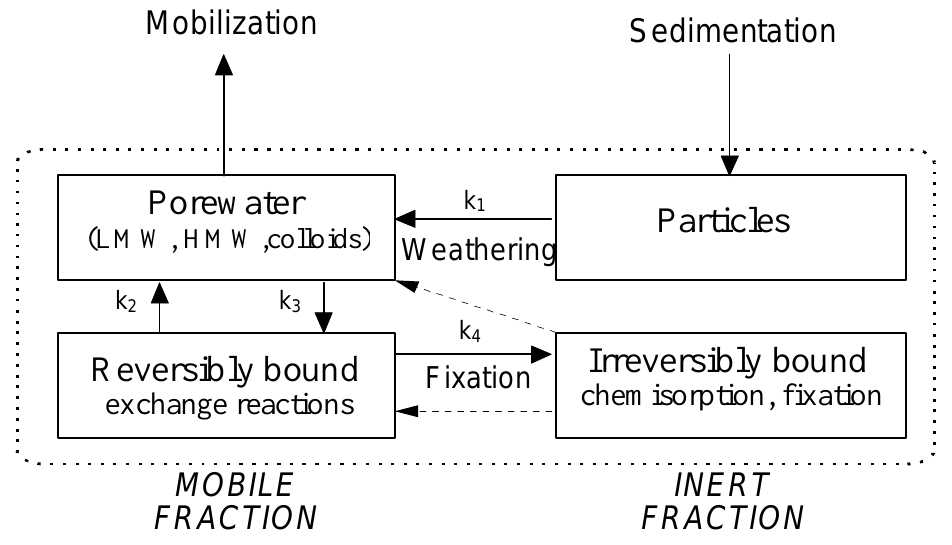
FIGURE 12 . Processes influencing the radionuclide species in